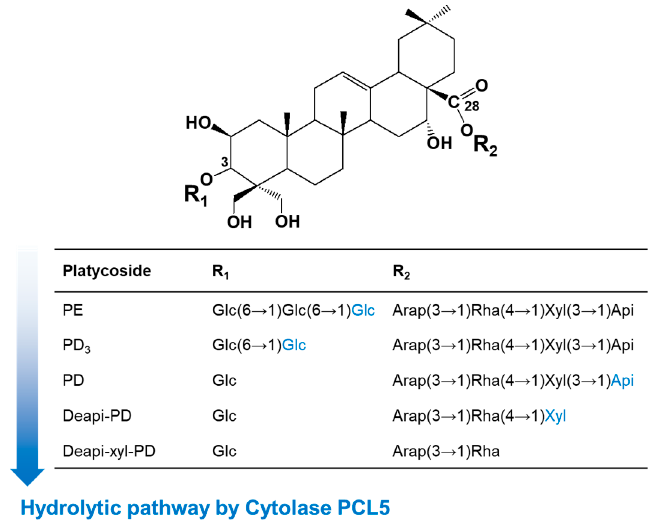
Figure 1. Chemical structure and hydrolytic pathway of platycoside E into deapiose-xylosylated platycodin D via intermediates platycodin D 3 , platycodin D, and deapiosylated platycodin D cat- alyzed by cytolase PCL5. PE, platycoside E; PD 3 , platycodin D 3 ; PD, platycodin D; Deapi-, deapisoy- lated; Deapi-xyl-, deapiose-xylosylated; Glu, β - D -glucopyranosyl-; Arap, α - L -arabinopyranosyl-; Rha, α - L -rhamnopyranosyl-; Xyl, β - D -xylopyranosyl-; and Api, β - D -apiofuranosyl-.